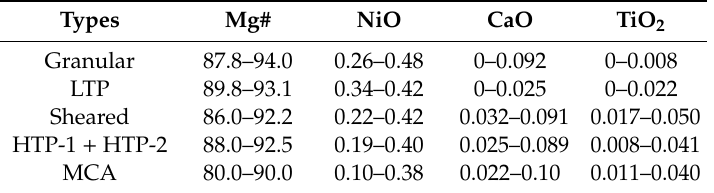
Table 2. Composition variations in olivine groups distinguished according to texture and formation temperature of peridotite: granular or sheared, after work in [7,11] and LTP or HTP-1 + HTP-2 (this study), respectively. HTP-1 and HTP-2 are two subtypes of high-temperature peridotites and belong to one